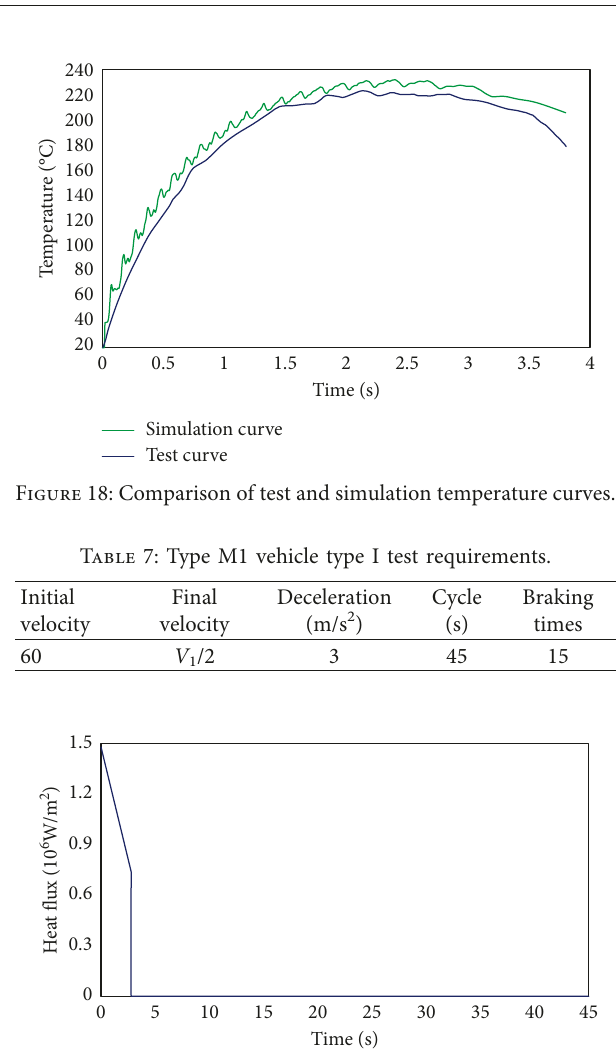
Figure 19: The heat flux of a cycle braking period.